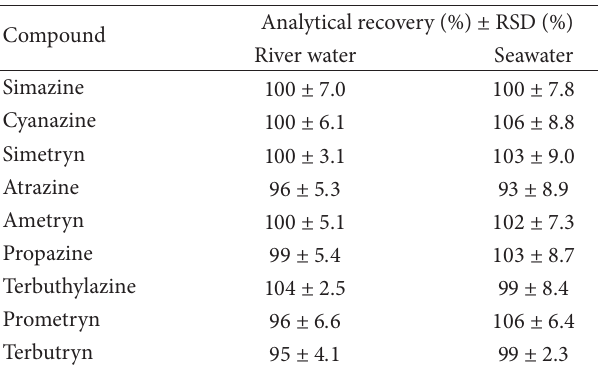
Table 2: Study of analytical recovery in river and sea waters (2 𝜇 g L − 1 , 𝑛 = 5